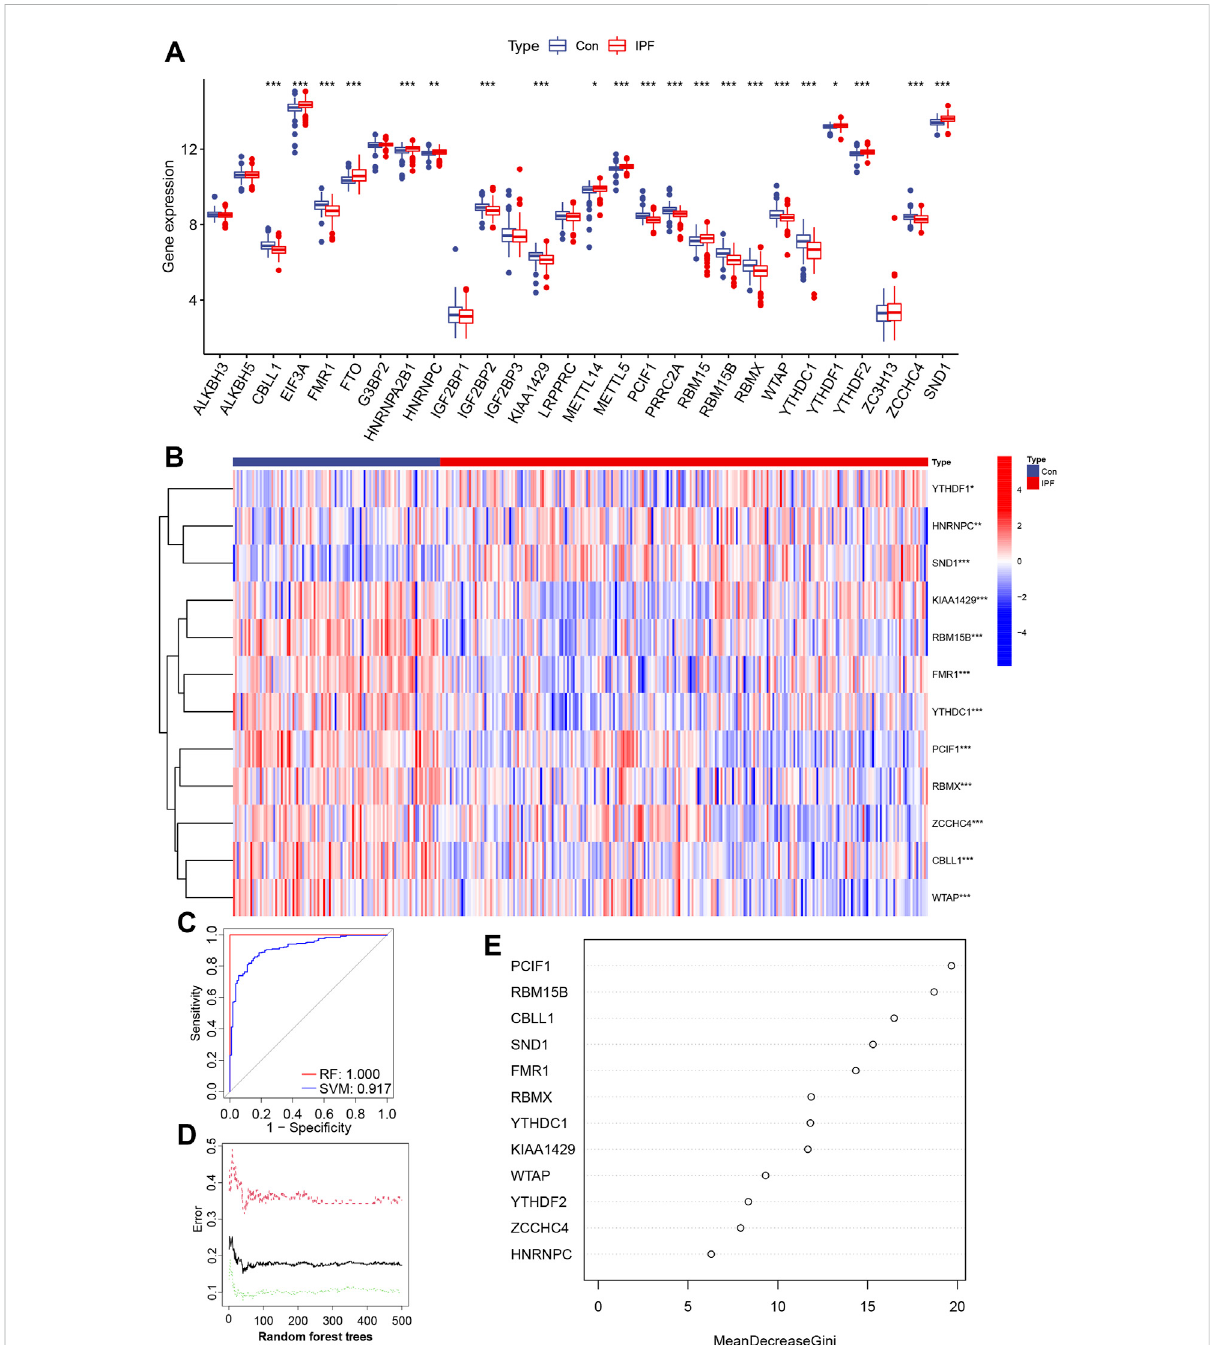
FIGURE 1 GSE47460 series pro fi le and RF and SVM model construction of m6A regulators in IPF and healthy volunteers (Con) (A) Histogram of 28 m6A regulators between IPF and Con. (B) Heatmap of differential expression of 12 m6A regulators. (C) AUC of the RF and SVM model, SVM is 0.917, RF is 1.000. (D) Correlation between the error and number of trees of Con, IPF, and both. (E) The importance scores of 12 m6A modulators were calculated based on the RF model. (* p < 0.05, ** p < 0.01, *** p <